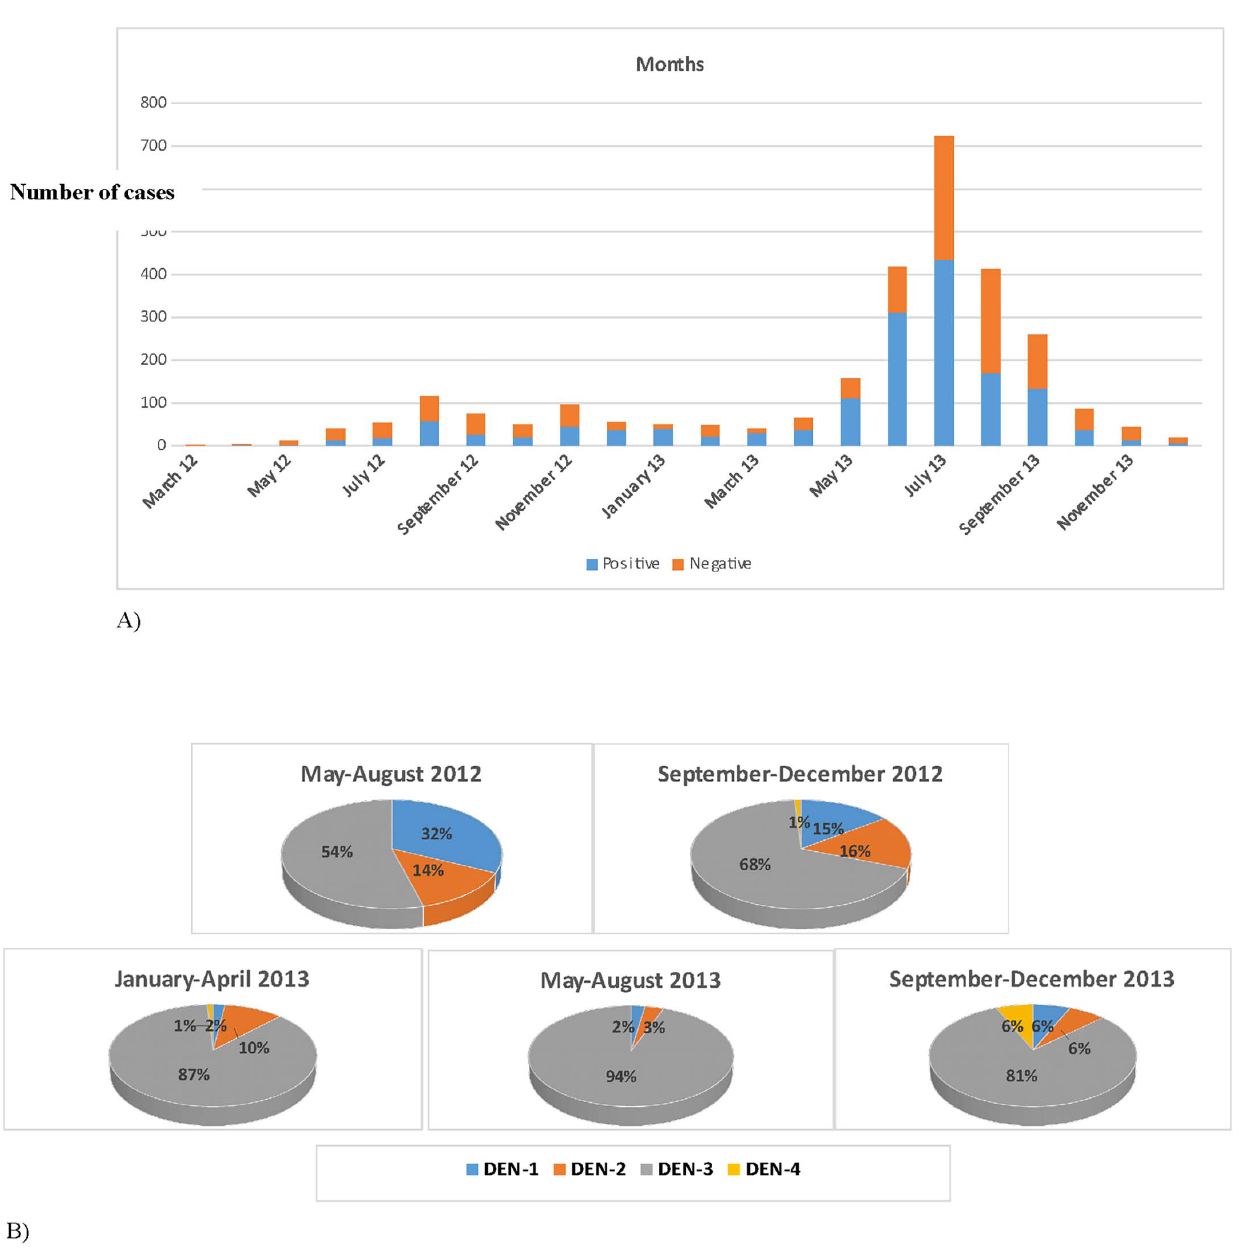
Fig. 1. Surveillance performed by Institut Pasteur du Laos from March 2012 to December 2013. (A) Distribution of confirmed cases (i.e. RT-PCR and/ or NS1 and/or culture positive) in Vientiane city (B). Dengue serotypes distribution in 2012 and 2013. Recording of dengue serotypes distribution on a four monthly basis. As the surveillance only started in late March 2012, partial data collected in April were not included in the figure.